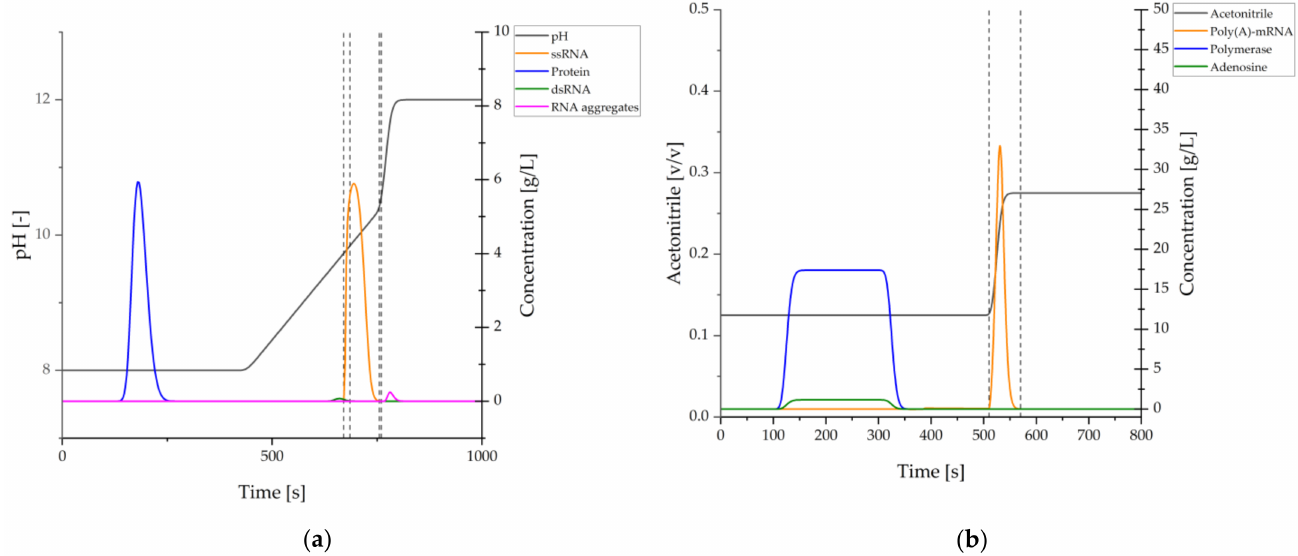
Figure 8. ( a ) Chromatogram of the batch separation on BIA CIMmultus PrimaS. ( b ) Chromatogramm of the batch separation on BIA CIMmultus Oligo dT18. Fraction cut points as dashed